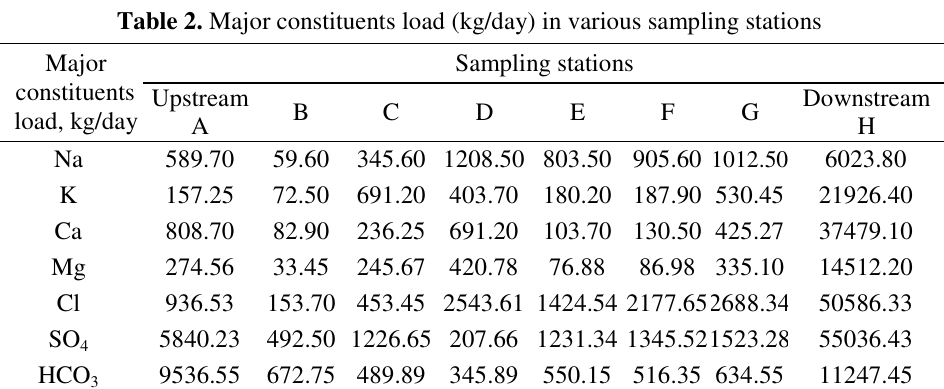
Table 2. Major constituents load (kg/day) in various sampling